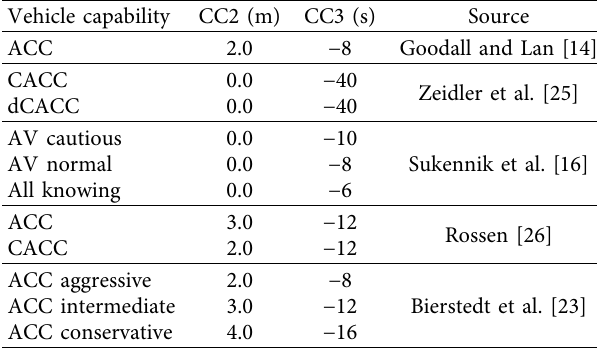
Table 2: Following variation (CC2) and threshold for entering “following” (CC3) regime from the Wiedemann 99 model.